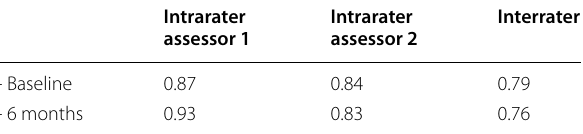
Table 3 Intraclass correlation coefficients (interrater and intrarater) of the MRI measurements by the two